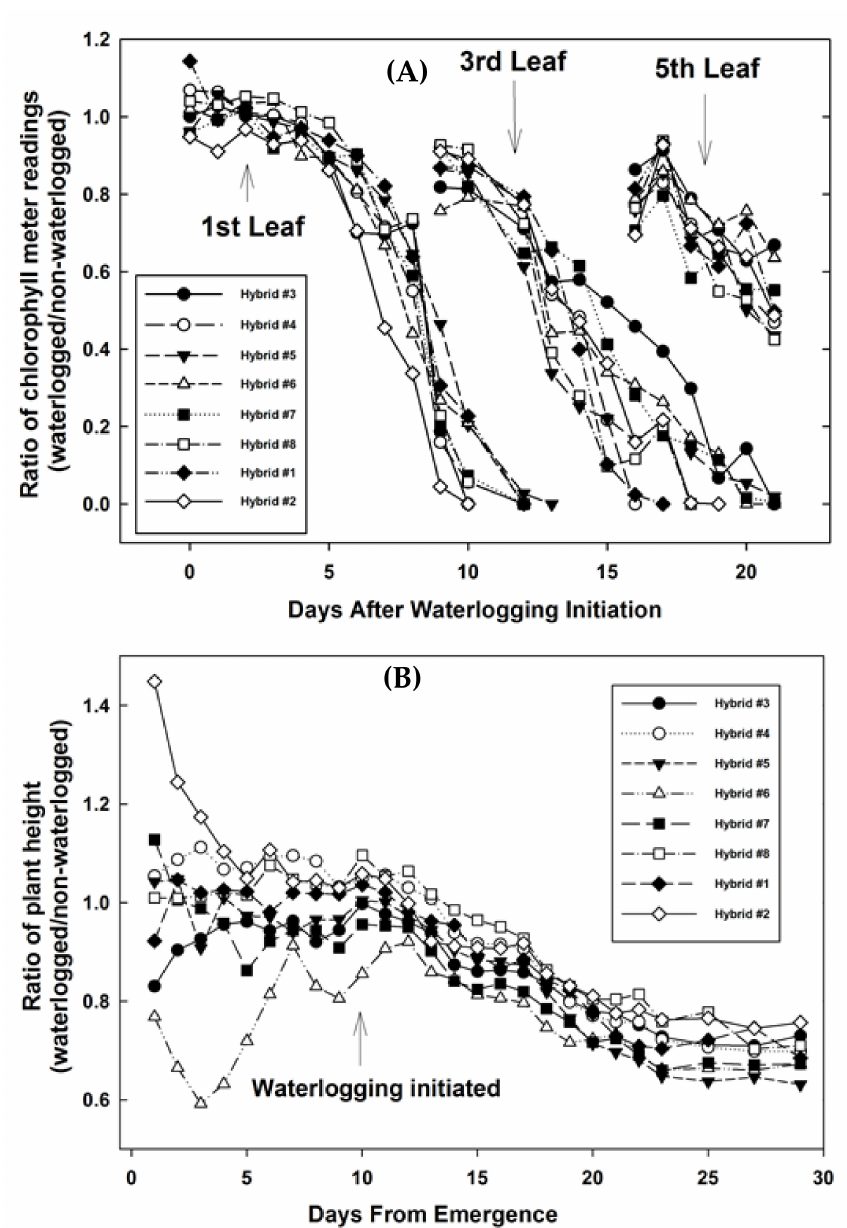
Figure 8. Ratio of 21-day waterlogged to nonwaterlogged treatment by corn hybrids for chlorophyll meter readings ( A ) and plant heights ( B ) by corn